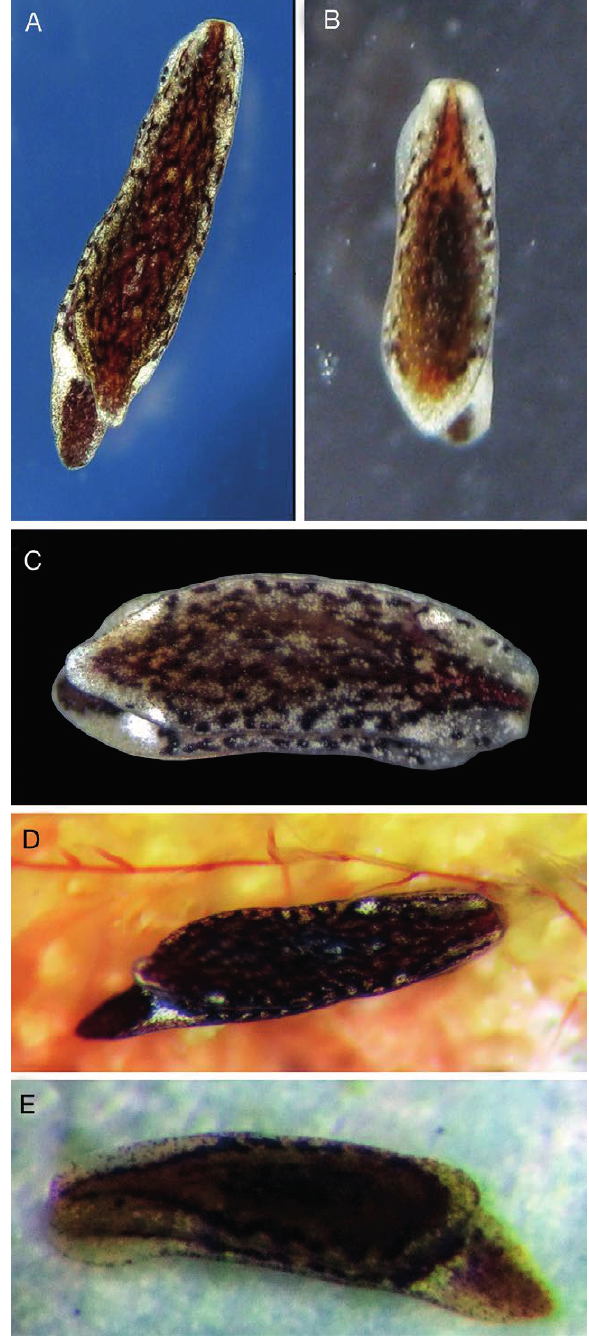
Fig. 2. – Living animals of Runcina brenkoae . A (MNCN 15.05/88086), B (MNCN 15.05/88089), C (MNCN 15.05/88088); specimens from Croatia (Adriatic Sea) (photos Alen Petani). D (MNCN 15.05/88087), E (MNCN 15.05/88090); specimens from Catalonia, Spain (Mediterranean) (photos Marina